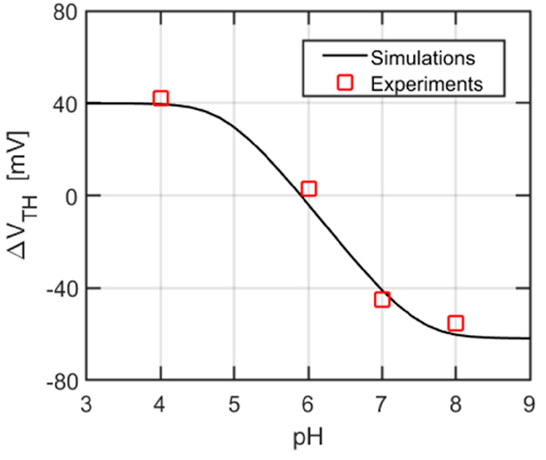
Figure 8. Threshold voltage variation with pH and simulation results obtained fitting the associated SB model.